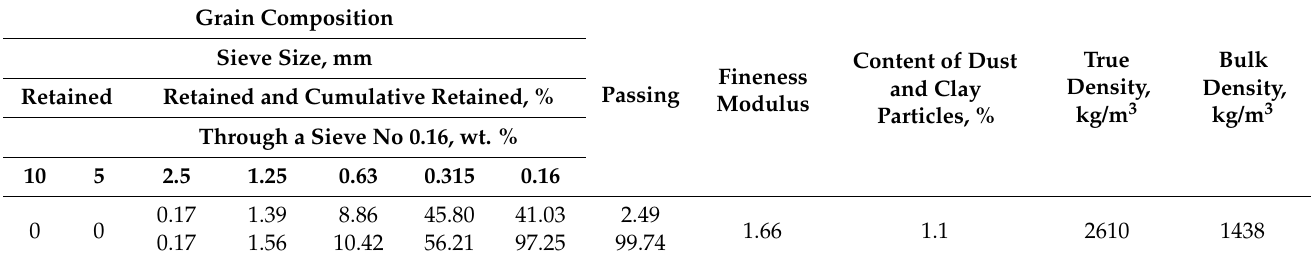
Table 5. Physical characteristics of dense fine